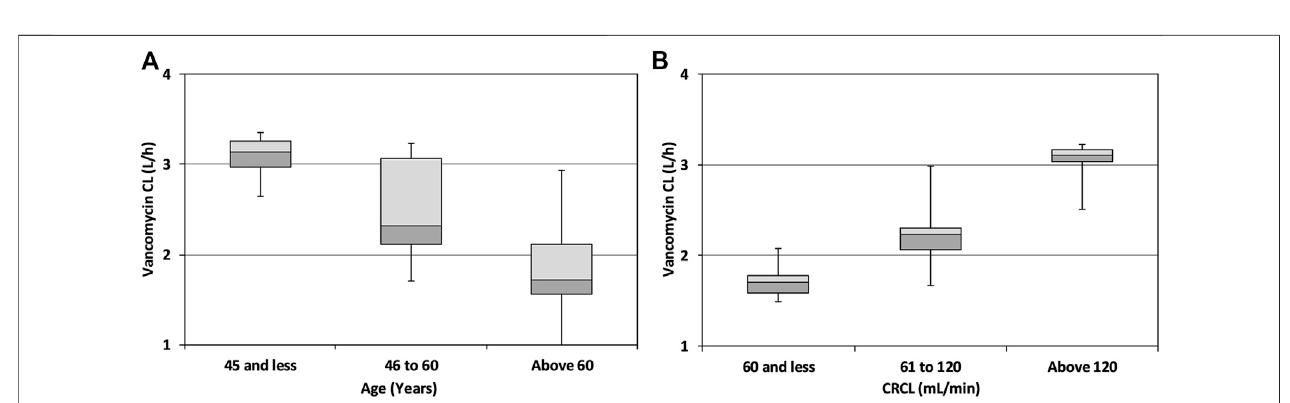
FIGURE 2 | Box and whisker plots showing categorical change in vancomycin CL with age (A) and CRCL (B) of the patients after strati fi cation into three groups.